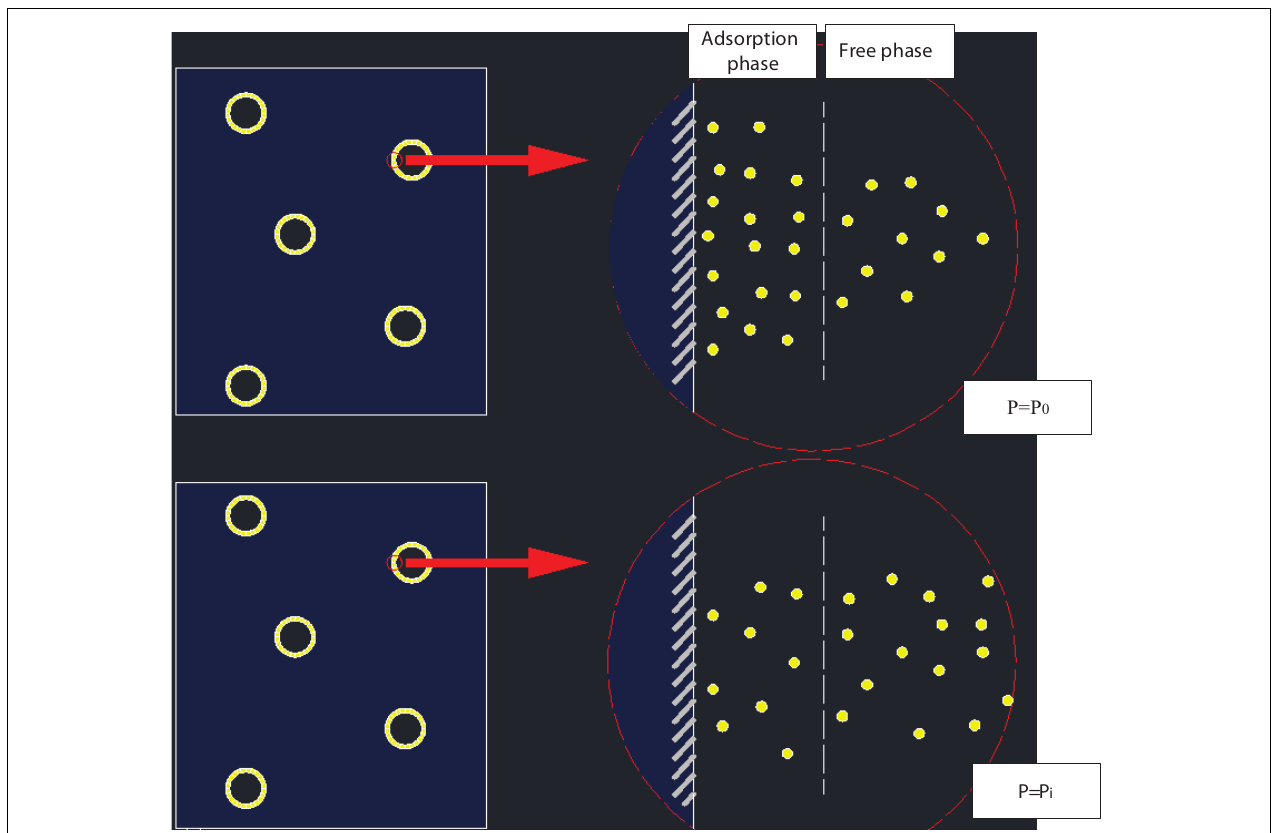
FIGURE 3 | Comparison of gas occurrence states of shale cores under different confining